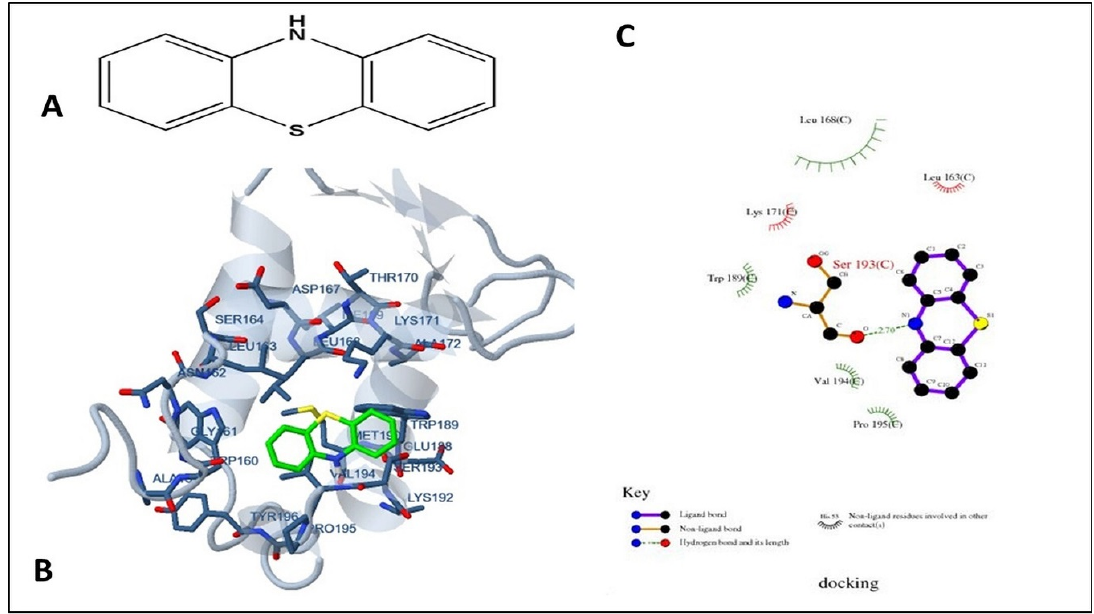
Figure 4. Molecular docking of phenothiazine with FOXO1 protein. ( A ) Depicting the molecular structure of phenothiazine; ( B ) Structure visualization of FOXO1 protein bound with ligand PTZ. The interacting residues are labeled in the binding site. ( C ) 2D plot of phenothiazine of FOXO1 showing ligand–protein interaction profiled by AutoDock software of Docking Server. Leu163, Leu168, Lys171, Trp189, Val194, Pro195, and Ser193 residues of FOXO1 showed crucial interactions with the